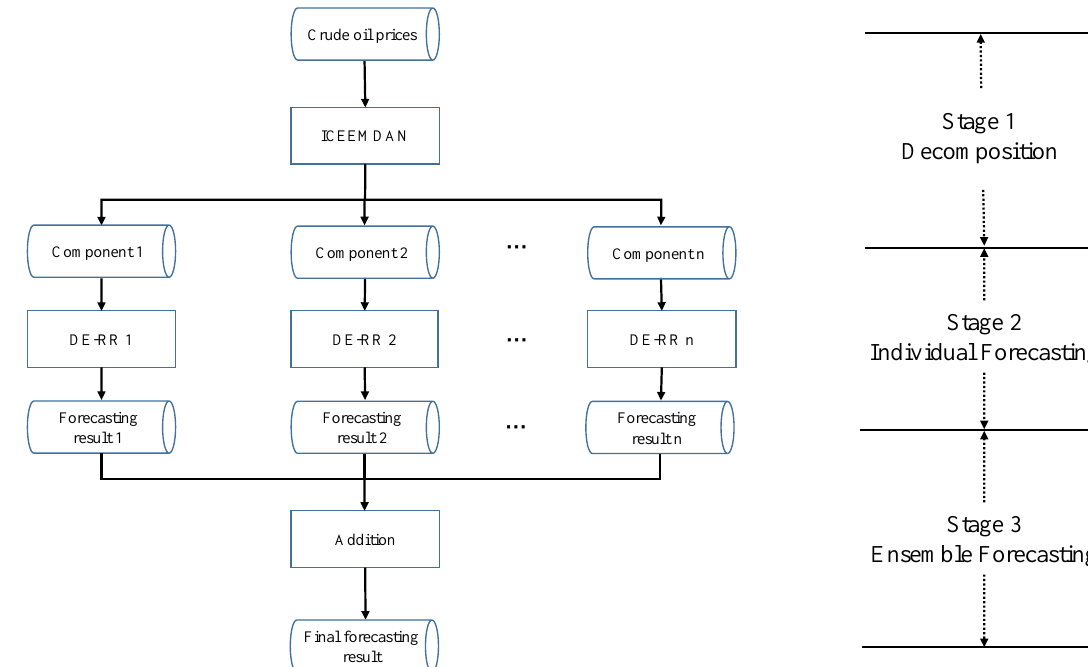
Figure 1. The flowchart of the proposed